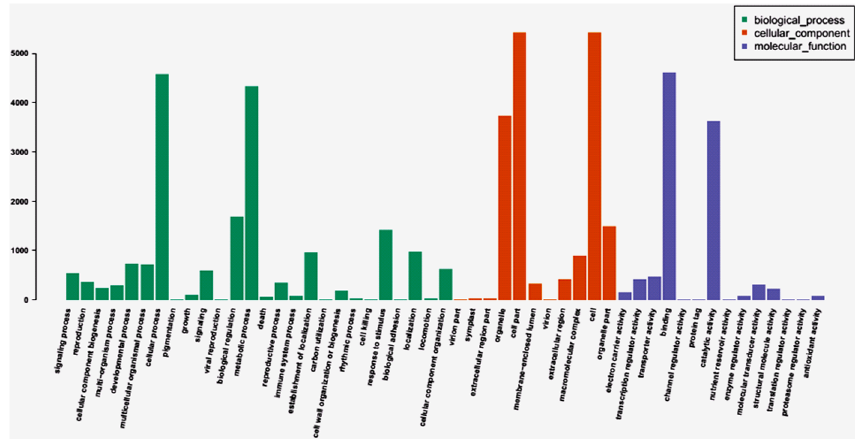
Fig 6. Gene Ontology categories of assembled unigenes. Unigenes were assigned to three main categories (biological processes, cellular components, and molecular functions) and 51 subcategories. The X-axis indicates GO term. The Y-axis indicates number of